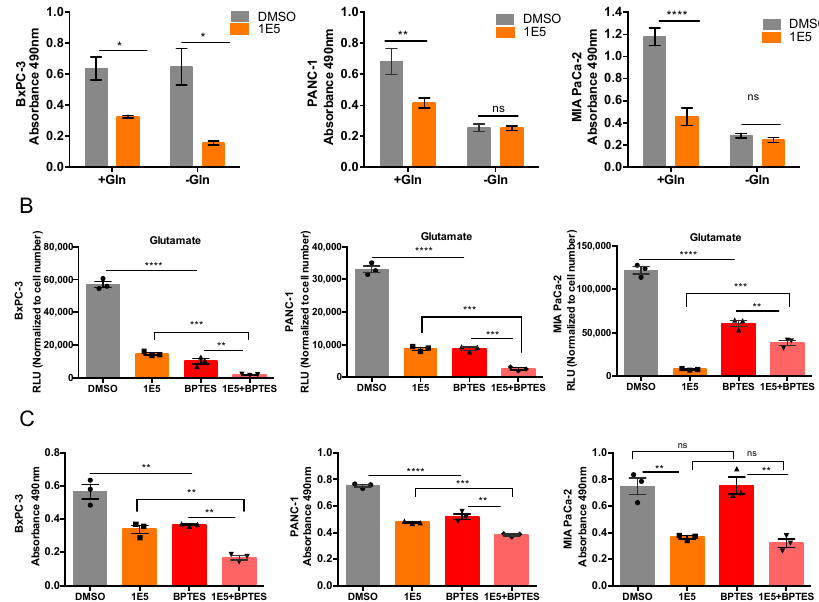
Figure 4. Combination treatment of 1E5 with a GLS inhibitor, BPTES, synergistically decreases intracellular glutamate levels and cell viability of PDAC cells. ( A ) MTT assay of PDAC cells cultured in media with or without 4 mM glutamine for 72 h. Data represent ± SEM and statistical significance determined by two-way ANOVA where * p < 0.01, ** p < 0.001, **** p < 0.0001, not significant (ns) p > 0.05. ( B ) Intracellular glutamate levels upon 48 h treatment with DMSO, 1E5 (10 µ M), BPTES (10 µ M), 1E5 (5 µ M) + BPTES (5 µ M) in BxPC-3, PANC-1, and MIA PaCa-2 cells. ( C ) Cell viability test in BxPC-3, PANC-1, and MIA PaCa-2 cells, respectively, n = 3 independent biological replicates. Data represent ± SEM and statistical significance determined by one-way ANOVA, where ** p < 0.01, *** p < 0.001, **** p < 0.0001, not significant (ns) p >